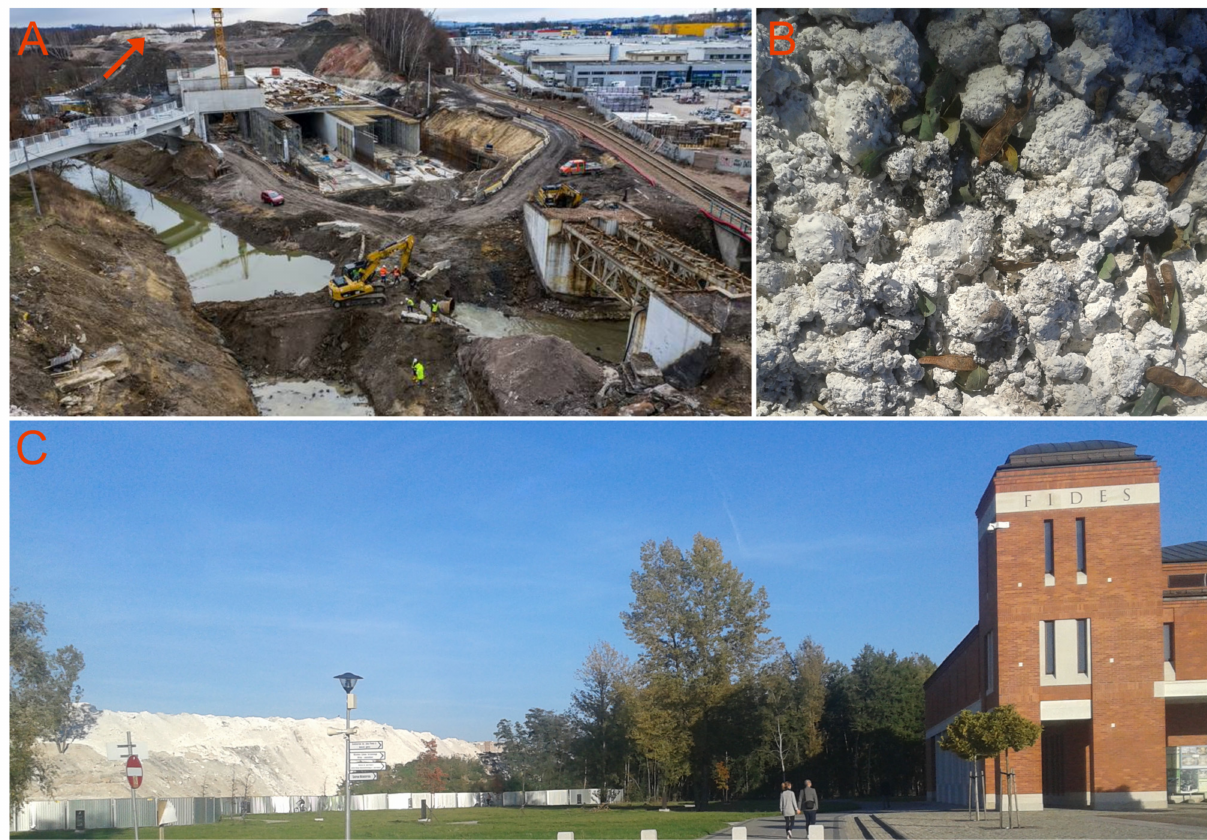
Figure 3. Wastes of former “Solvay” Krak ó w Soda Works, so-called “White Seas” (pol. Białe Morza): ( A )—vicinity of sampling point No. 6 (Figure 1) during construction works and relocation of the Wilga River bed (obtained courtesy of Trasa Łagiewnicka S.A. [59]), with waste piles visible in the background (red arrow); ( B )—soda waste up close; ( C )—non-processed soda waste piles in the vicinity of the Wilga River, next to the recultivated and redeveloped